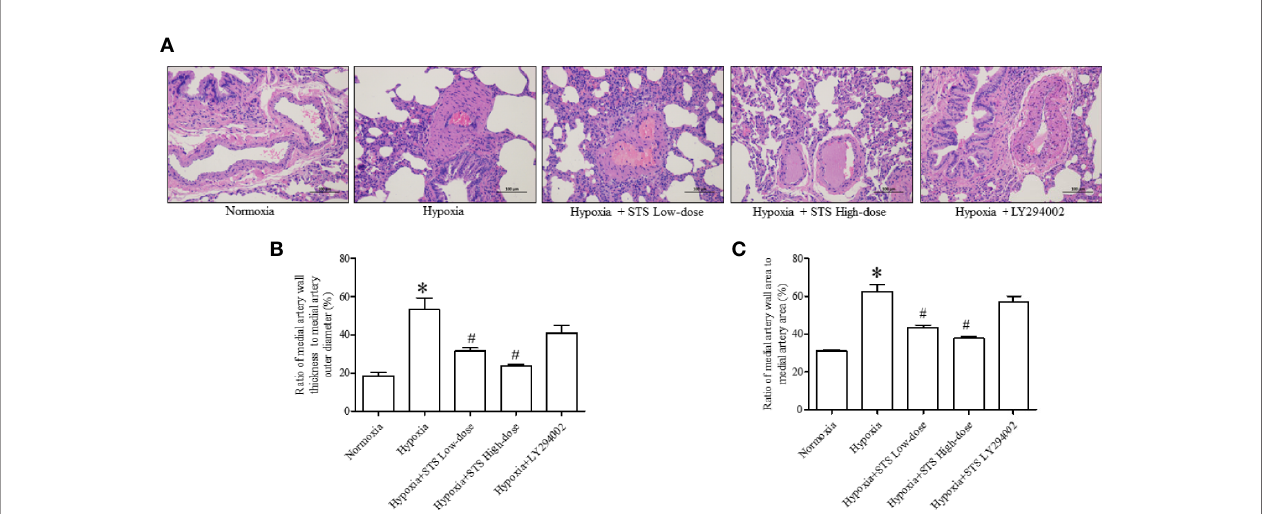
FIGURE 4 | Histological analysis of lung medial artery thickness. (A) Representative histological images of HE staining of lung medial artery area in each group. (B) Ratio of medial artery wall thickness to artery outer diameter in each group. (C) The ratio of medial artery wall area to medial artery area of each group. Data are presented as mean ± SEM (n = 6). * P < 0.05 compared with normoxia group, # P < 0.05, compared with hypoxia